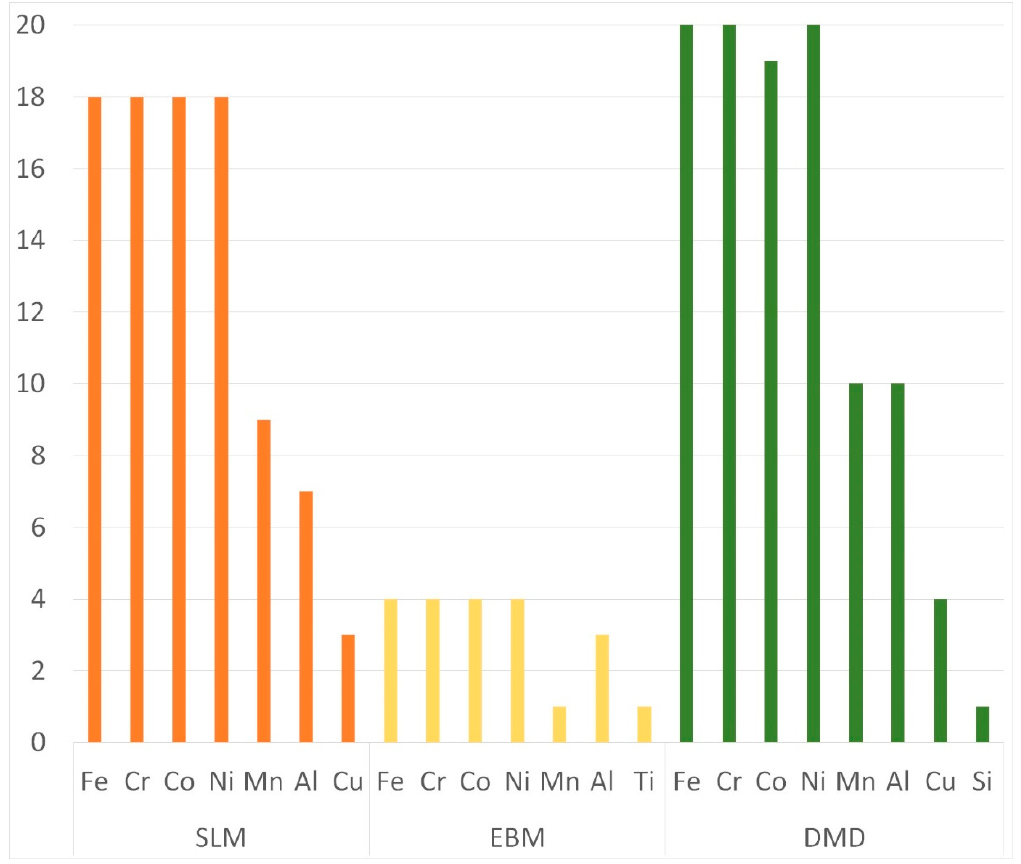
Figure 2. Frequency (number of papers) of elements used in the AM HEAs.